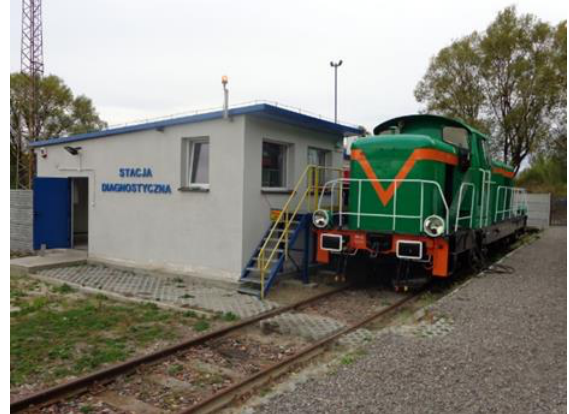
Fig. 5. Scheme of PEMS analyzer based on Semtech DS [12] FID (Flame Fig. 4 . Diagnostic station for measuring operational parameters and emis- Ionization Detector), NDUV (Non–dispersive Ultra Violet), NDIR (Non– sions of rail vehicles [20] dispersive Infrared), OBD (On-Board Diagnostics), GPS (Global Position- ing System), LAN (Local Area